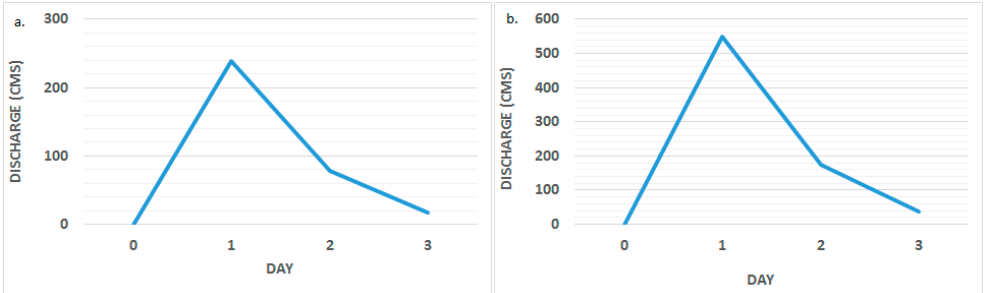
Figure 6. The river discharge/peak flow generation by HEC ‐ HMS based on the 50 ‐ year return period for the ( a ) current scenario and ( b ) future scenario.